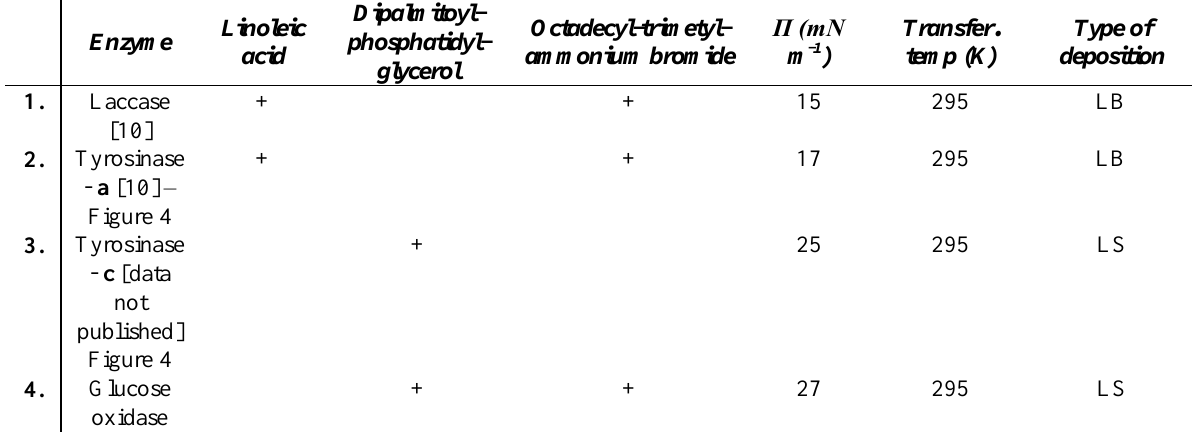
Table 2. Compositions of LB/LS films and their transfer conditions.